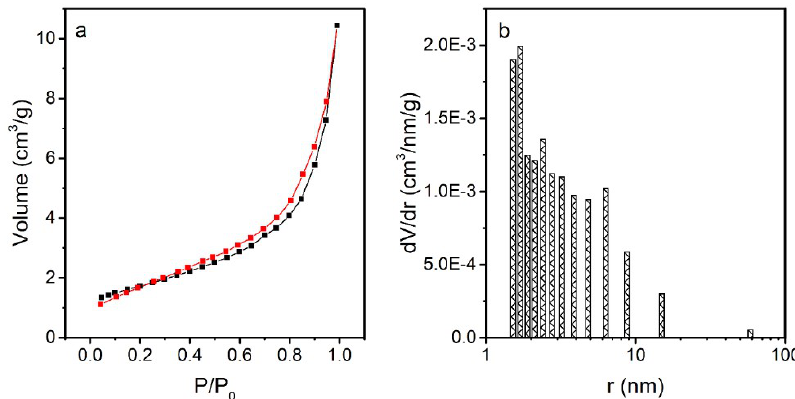
Figure 6. Low-temperature N 2 adsorption study results for a Ni 2 Mo 3 N sample heat-treated in H 2 /N 2 atmosphere at 650 °C. ( a ) Adsorption (black) and desorption (red) isotherms; ( b ) pore-size distribution calculated by means of the BJH method.